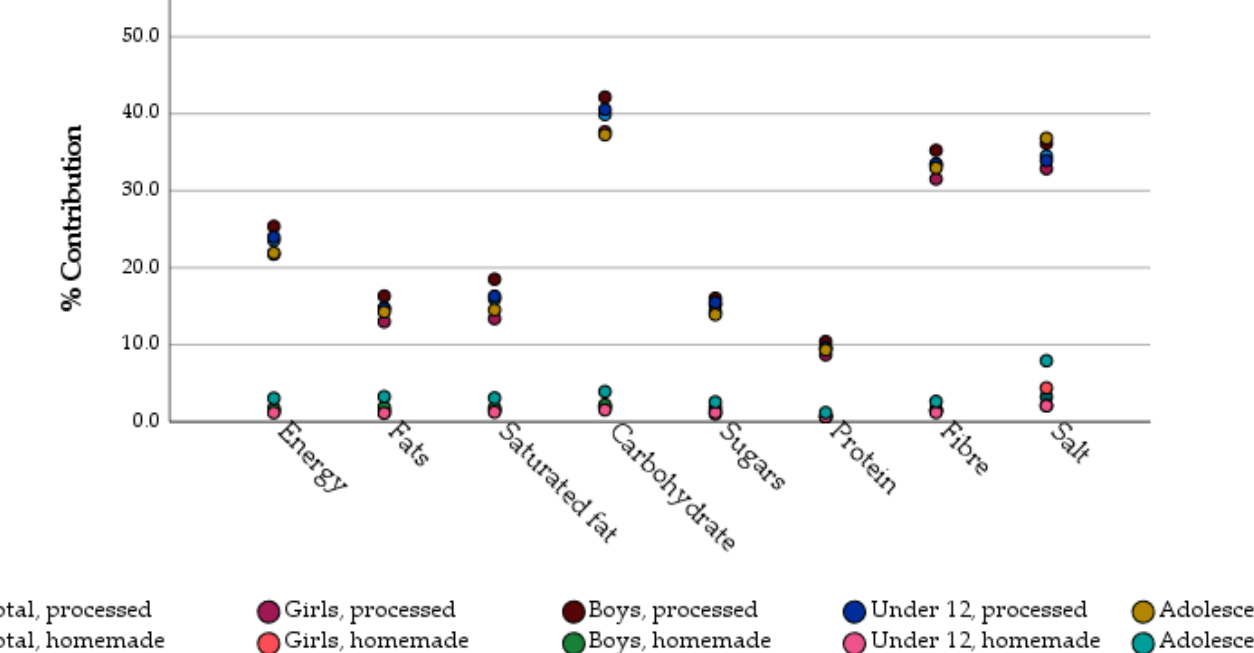
Figure 1. Contribution of processed and homemade gluten-free products to the diet (energy and nutrient content) of Spanish children and adolescents with celiac disease depending on gender and age. Data are expressed as average ± standard deviation. There are statistics differences ( p < 0.01) in the contribution of energy and nutrients to total diet between processed vs. homemade in all cases.